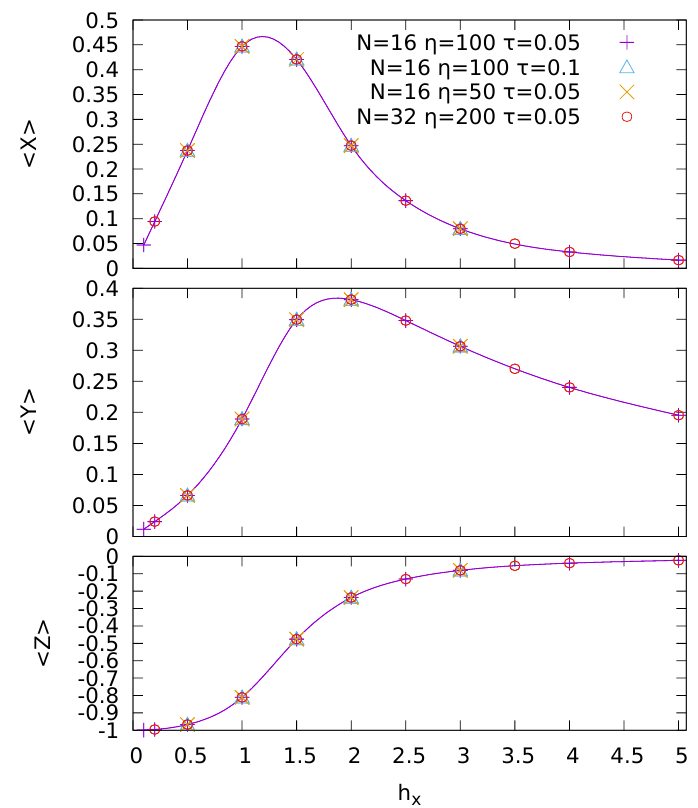
Figure 18: Expectation values 〈 X 〉 , 〈 Y 〉 and 〈 Z 〉 in the steady state of a dissipative quantum Ising ring as a function of h The simulation parameters η (maximum bond dimension) and τ (time step) are varied, showing the very good convergence of the results. The final time is t and cut_off_rho = 10 − 16 . The coincidence of the values for N = 16 and 32 indicates that the correlation length is short. The line is a guide to the